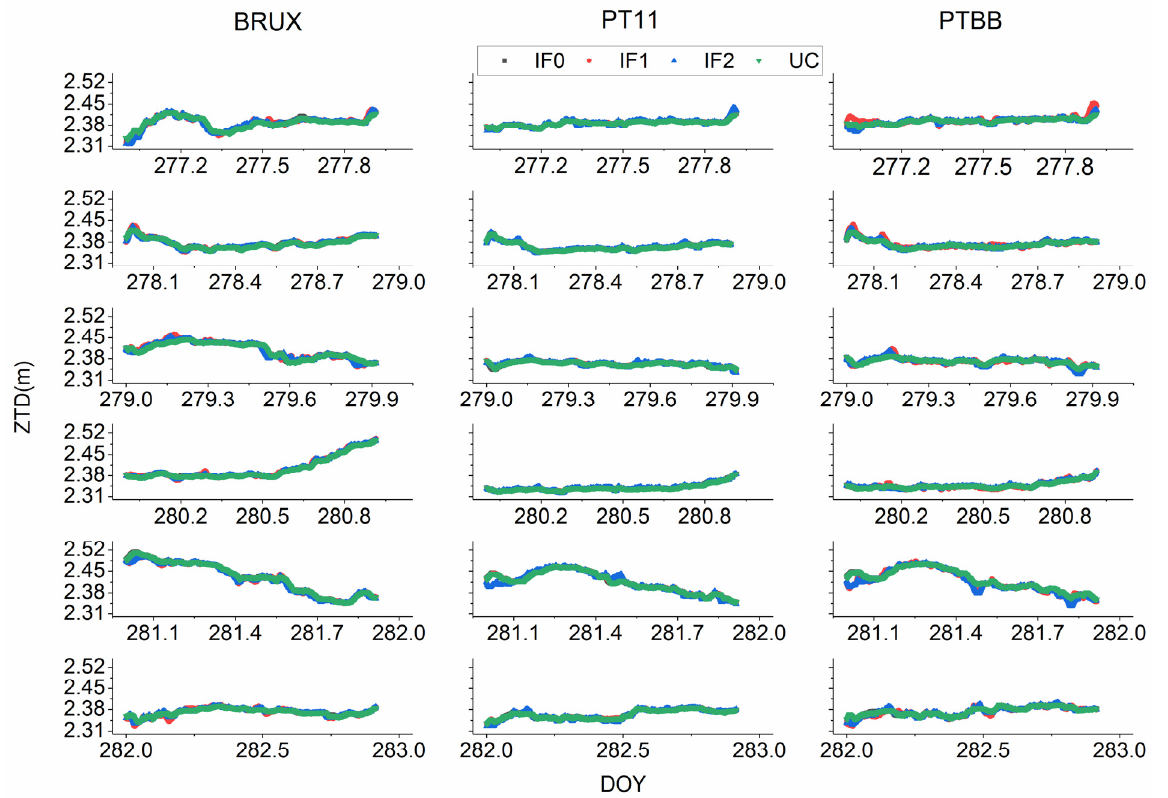
Figure 20. Zenith troposphere delay between different Galileo PPP methods.